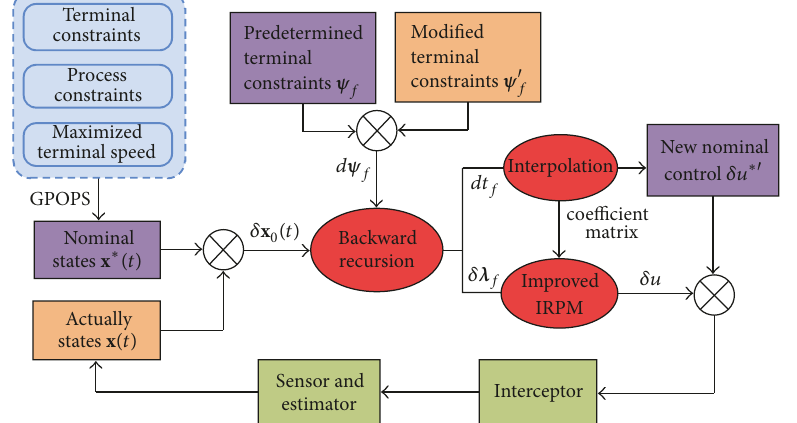
Figure 2: Online neighboring optimal modified algorithm.